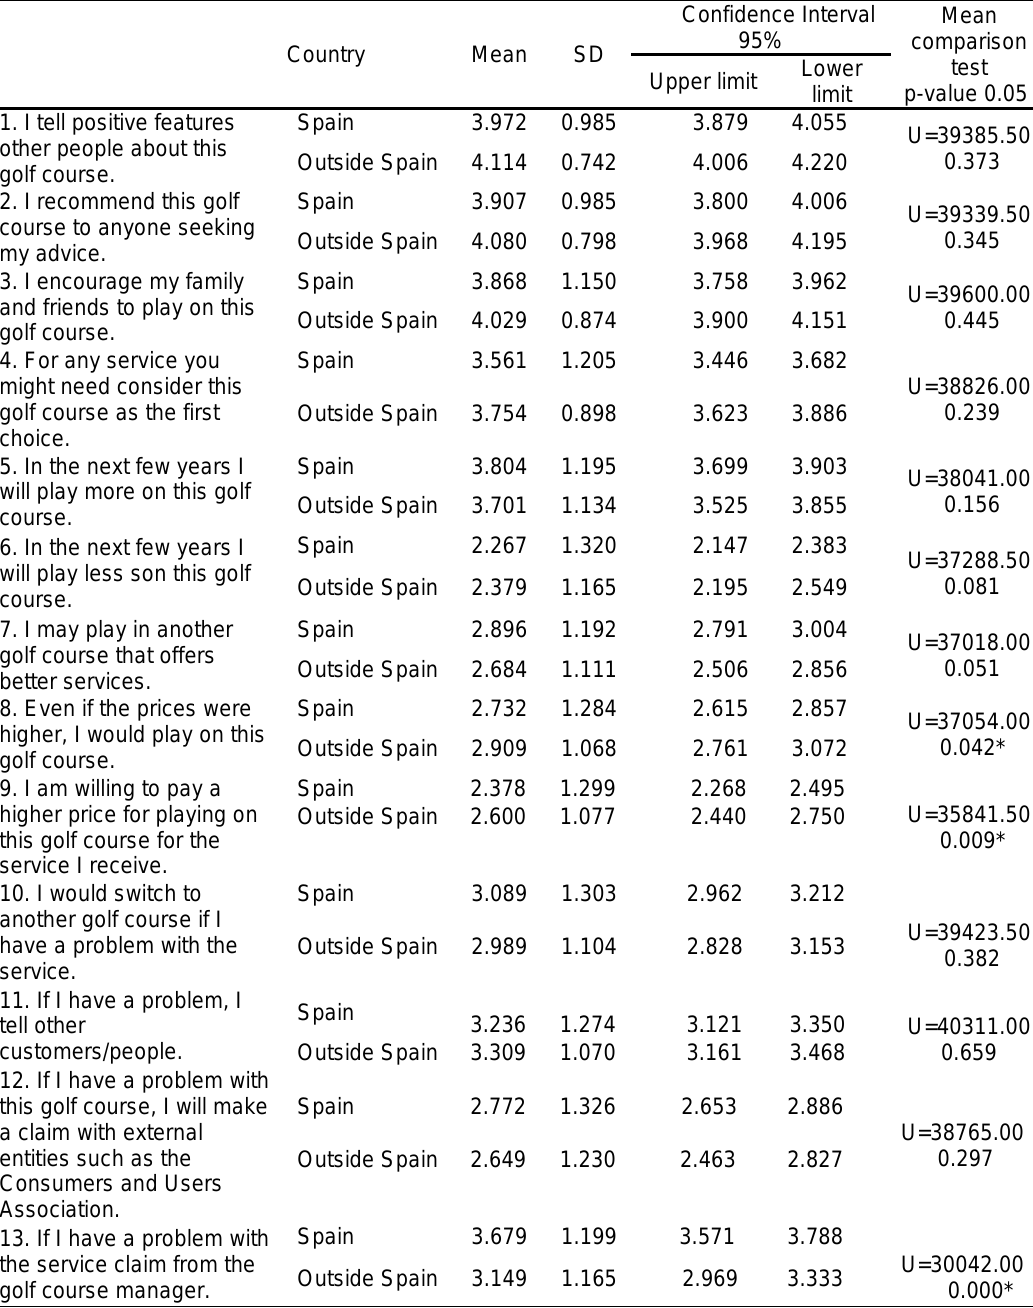
Table 3. Bivariate analysis of the Loyalty (V1-5), Price Sensation (V6-9) and Response (V10-13) dimensions according to the country where they